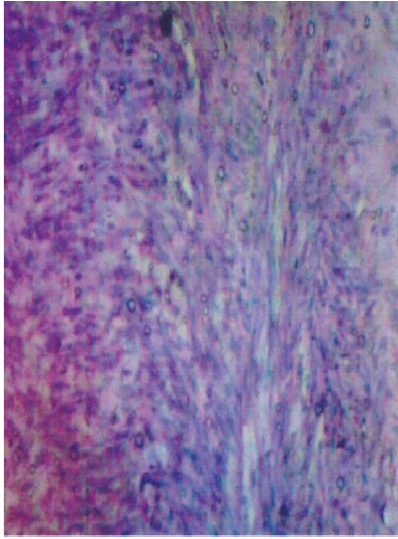
Figure 4: The microscopic slide of the histology.